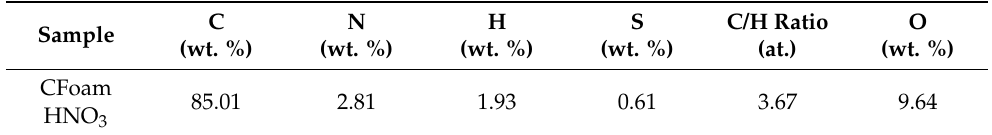
Table 1. Content of elements in activated carbon foam